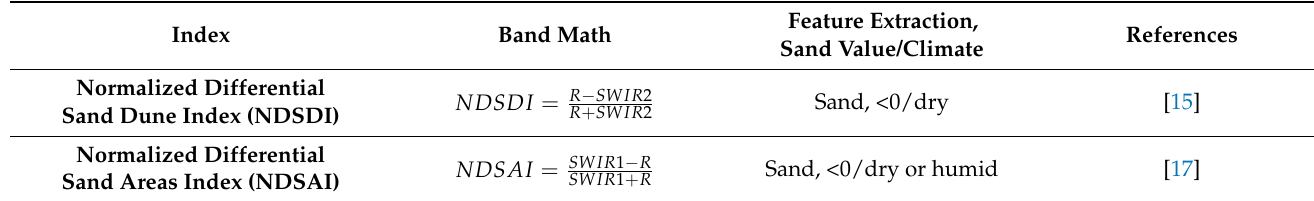
Table 3. Indices used to extract sandy